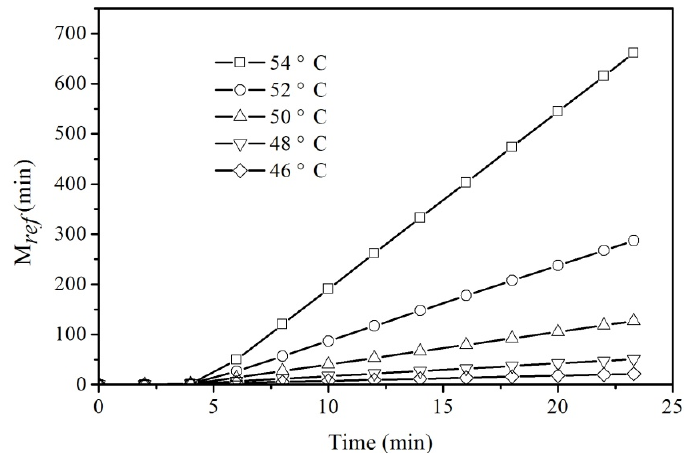
Figure 6. The cumulative lethal time M ref for R. dominica as a function of treatment time at four heating temperatures at the reference temperature of 46 °C.